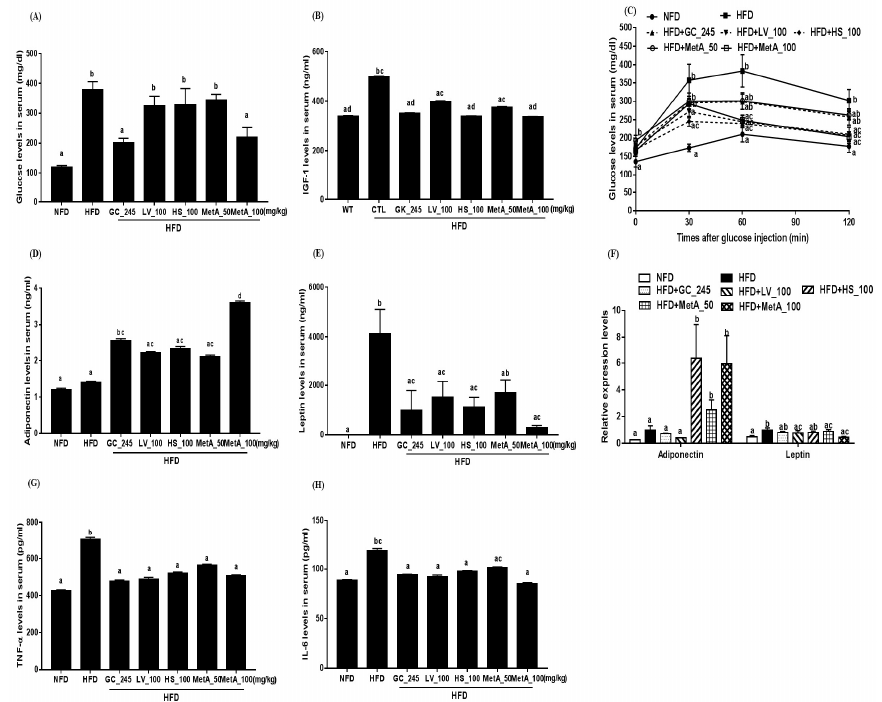
Figure 6. Effect of LV, HS, and MetA on systemic glucose tolerance in HFD-induced obese mice. Serum glucose levels ( A ), serum IGF-1 levels ( B ), intraperitoneal glucose tolerance test ( C ), serum adiponectin levels ( D ), serum leptin levels ( E ), adiponectin and leptin mRNA expression in EWAT ( F ), serum TNF- α levels ( G ), and serum IL-6 levels ( H ). Adipokines were quantified using enzyme-linked immunosorbent assay (ELISA) and an intraperitoneal glucose tolerance test (IGTT) was performed at 8 weeks on HFD (at 18 weeks of age). HFD, 60% high fat diet control group; HFD + GC_245, HFD contains Garcinia cambogia extract (245 mg/kg)-fed group; HFD + LV_100, HFD contains lemon verbena extract (100 mg/kg)-fed group; HFD + HS_100, HFD contains Hibiscus flower extract (100 mg/kg)-fed group; HFD + MetA_50, HFD contains the MetA-mixed extract of lemon verbena plus Hibiscus flower (50 mg/kg)-fed group; HFD + MetA_100, HFD contains the MetA-mixed extract of lemon verbena plus Hibiscus flower (100 mg/kg)-fed group. Values are expressed as means ± SEM ( n = 10). a–d Values within arrow with different letters are significantly different from each other at p < 0.05 as determined using Turkey’s multiple-range